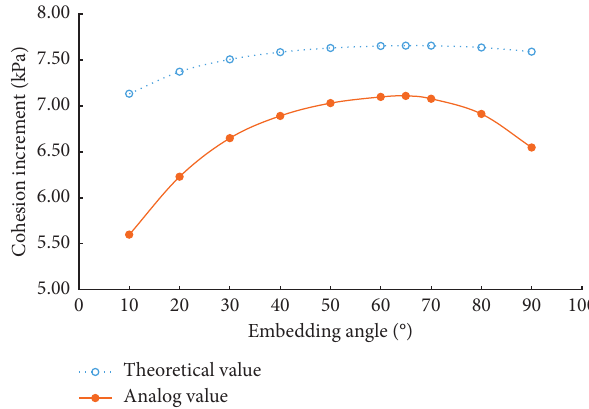
Figure 10: Relationship curve between root embedding angle and cohesion incremental.